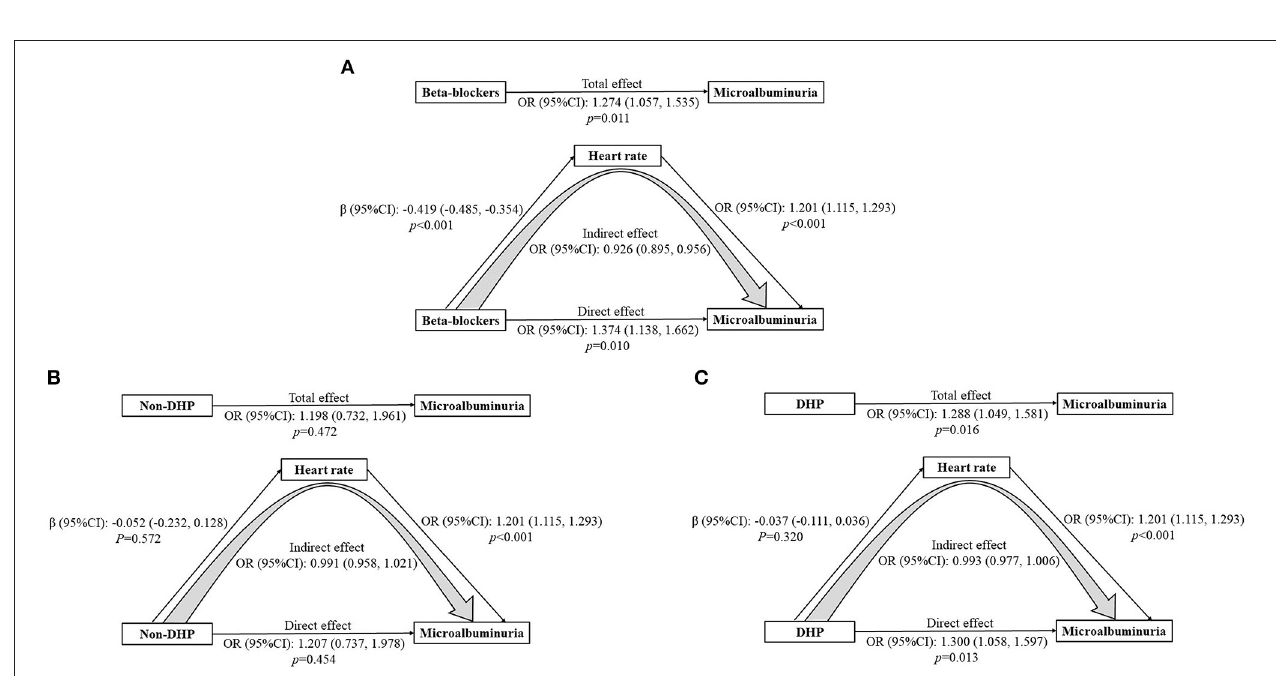
FIGURE 3 | Subgroup analyses for the association between the risk of microalbuminuria and heart rate.